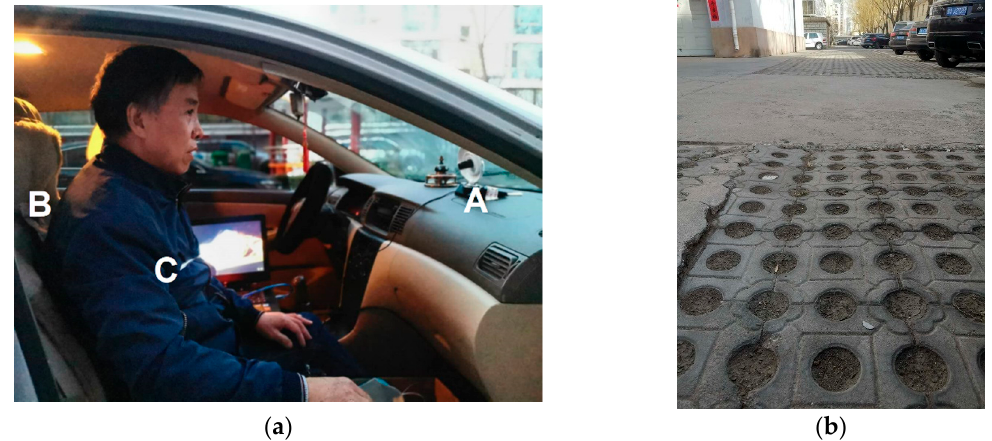
Figure 16. The experiment setup: ( a ) the experiment inside the car; ( b ) the experiment road.